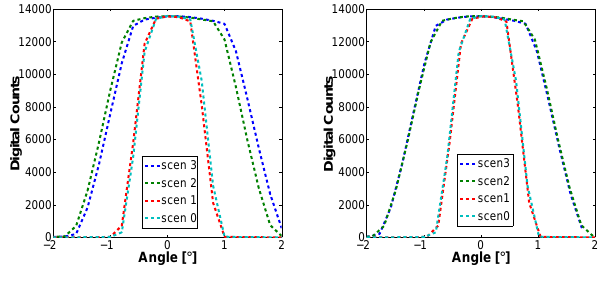
Fig. 6. On the left, cross measurements taken at the Valladolid site on 5 August 2010 at 13:41. The subfigure on the right shows the same measurement after applying a Sun movement correction on the